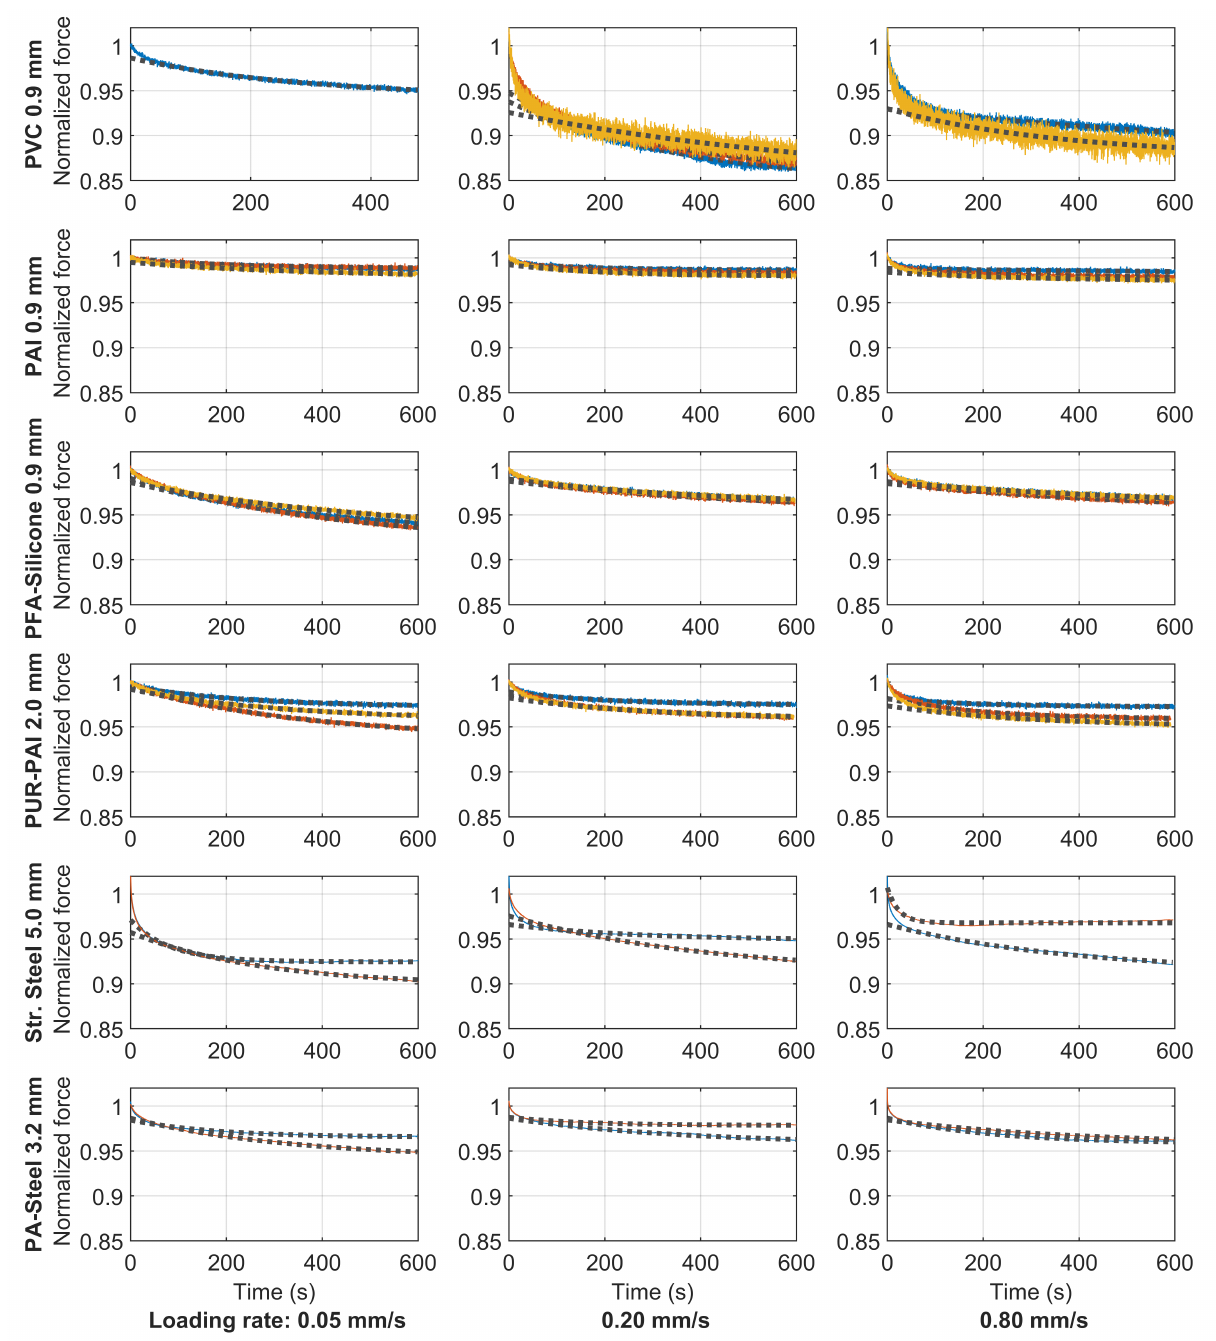
Figure 23. Comparison of force relaxation while holding displacement for different types of cable (color lines represent measurements of different samples while dotted lines represent the exponential fit to the